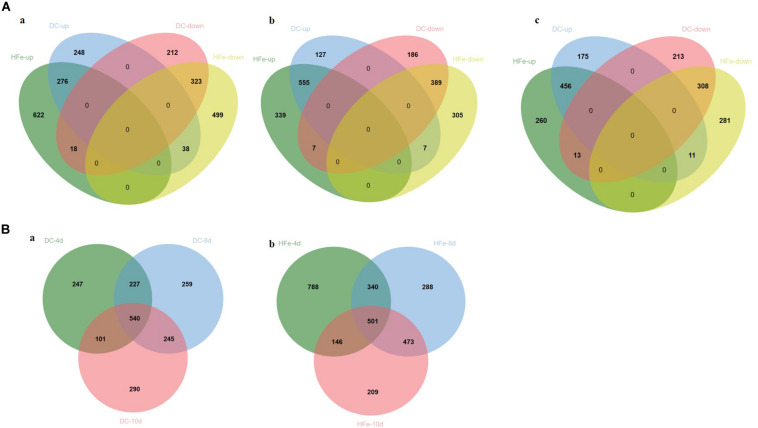
Number of common and specific significantly differentially expressed proteins in DC3000 with the addition of 20 μmol/L FeCl3 (DC) and 400 μmol/L FeCl3 (HFe) compared to the control group with no addition of FeCl3 (0Fe). (A) Venn diagrams showing upregulated and downregulated proteins between three time points, respectively, which are (a) 4 days after inoculation, (b) 8 days after inoculation, and (c) 10 days after inoculation. (B) Venn diagrams showing unique and shared upregulated and downregulated proteins between three time points, which are (a) 20 μmol/L FeCl3 (DC) compared to the control group (b) 400 μmol/L FeCl3 (HFe) compared to the control group, quantified in all three biological replicates with fold change >2 or <0.5 in quantity (p < 0.05). Venn analysis used the VennDiagram package (R, Version 1.6.20).